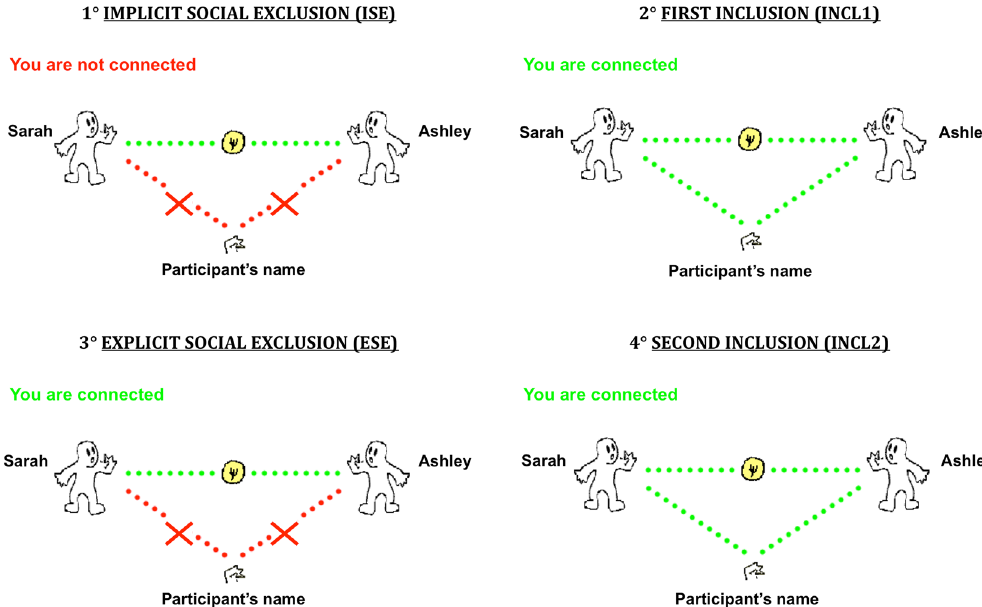
Figure 1. Illustration of the four successive experimental conditions: (1) Implicit social exclusion ( ISE ); (2) First inclusion ( INCL1 ); (3) Explicit social exclusion ( ESE ); (4) Second inclusion i.e., re-inclusion after social exclusion ( INCL2 ). Note. The illustration (including the little man) has been drawn, following initial Cyberball’s studies [see refs 16–19], by Pierre Maurage 33 who co-authored this